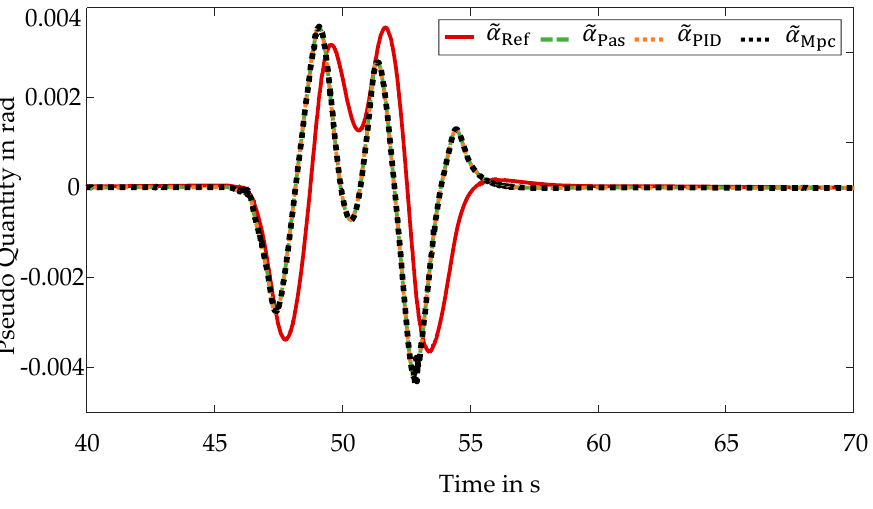
Figure 5. Control Quality Double Lane Change–Self-Steering Behavior–Pseudo Quantity Curves.